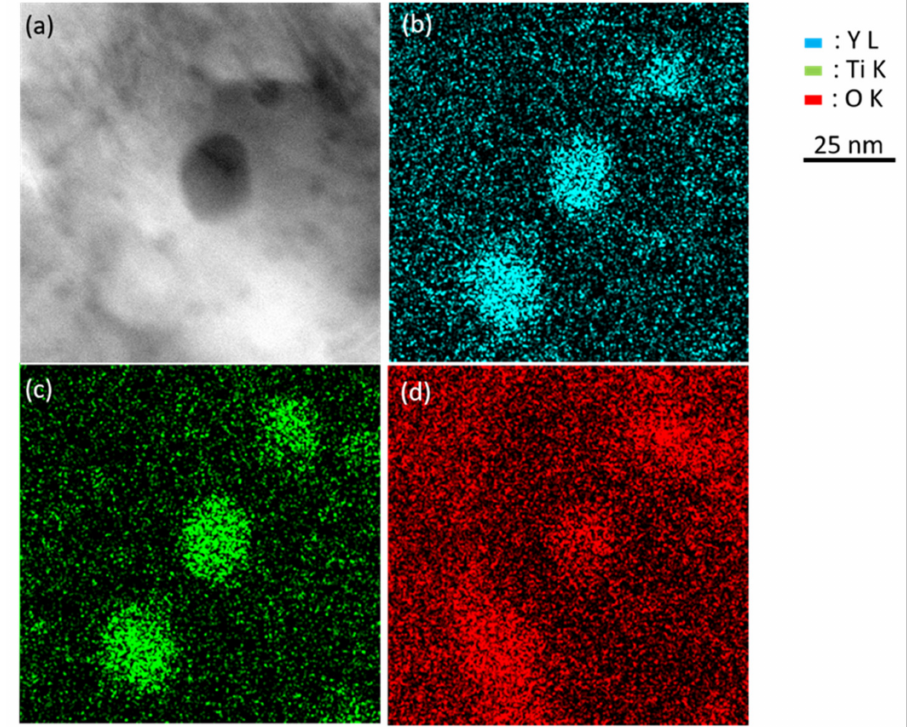
Figure 4. Chemical map of the nano-oxides from EDS acquisition: ( a ) ADF STEM image, ( b ) Y L ac-quisition, ( c ) Ti K acquisition, and ( d ) O K